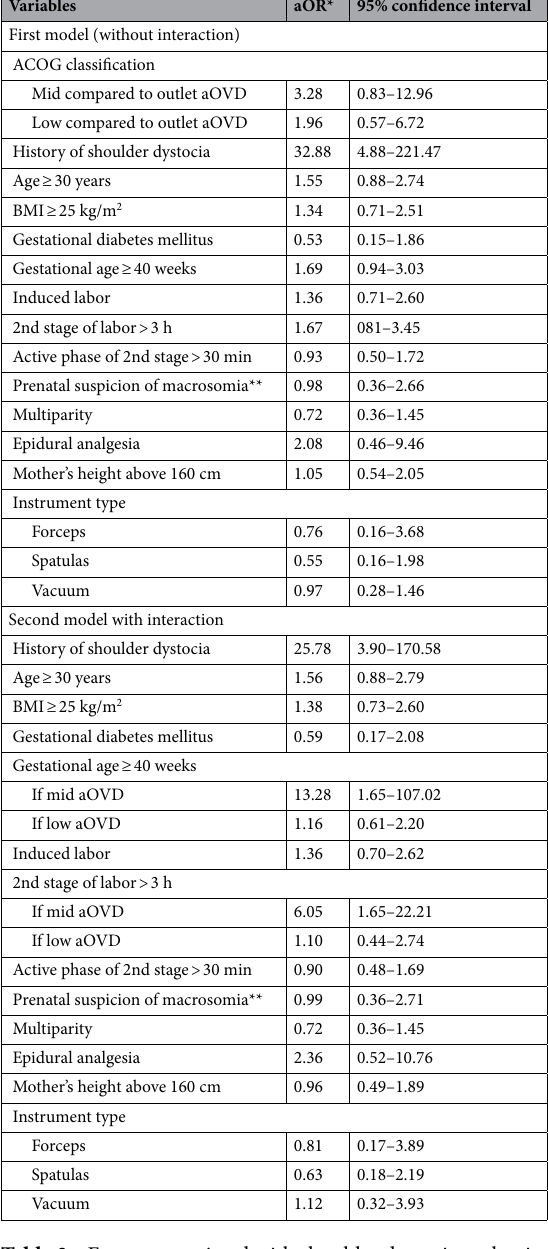
measurement at delivery > 37 cm and/or ultrasonographic fetal abdominal circumference > 90th percentile for gestational age on Hadlock